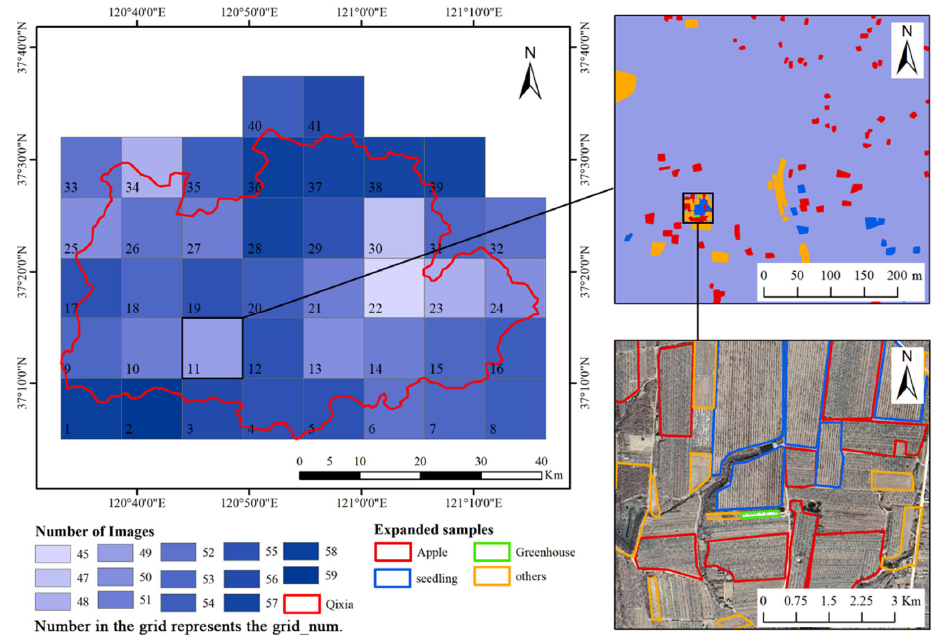
Figure 3. Grid division result. Points expanded into polygons.